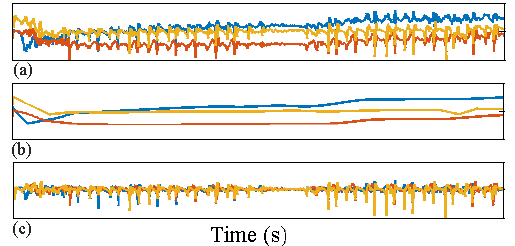
Figure 4. Raw accelerometer sensor output vector x for a single walking test (top panel); ( a ) raw acceleration data; ( b ) estimated gravitational orientation trend ˆ g ; ( c ) estimated dynamic acceleration after removing the effect of device